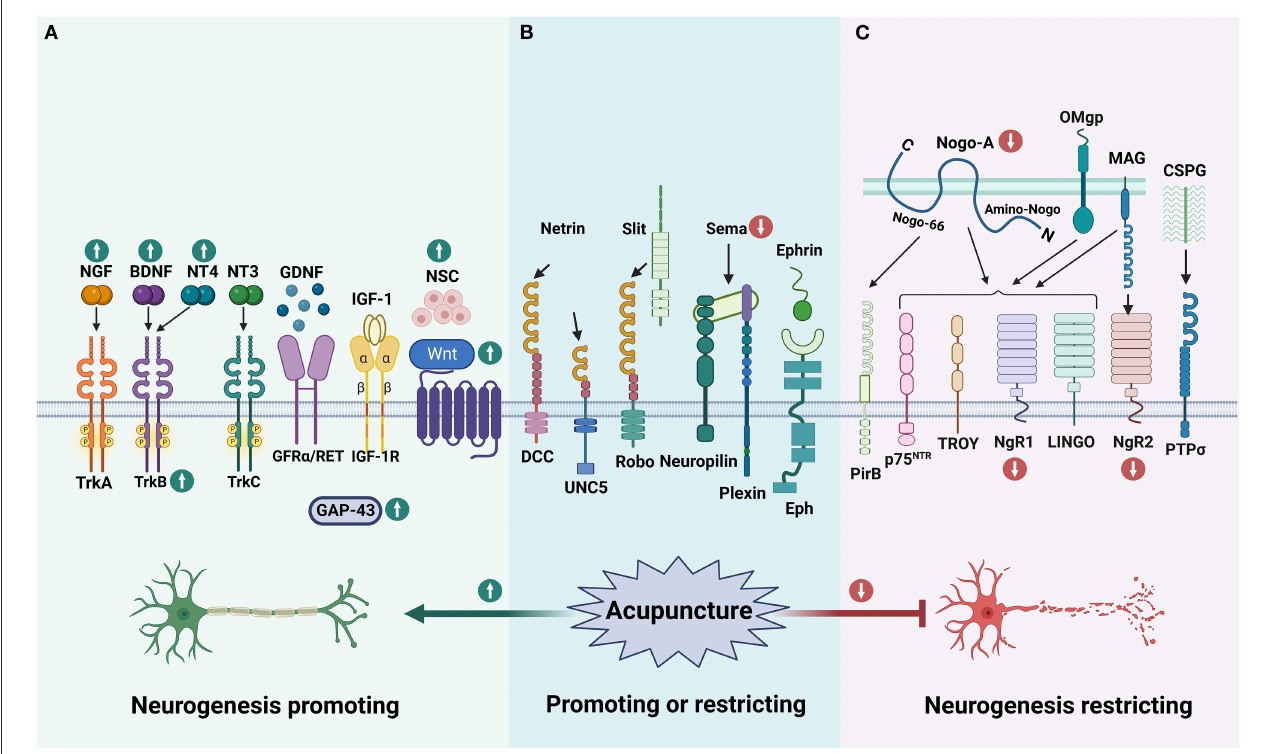
FIGURE4 The effect of acupuncture on neurogenesis impact factors. (A) Shows enhancers for neurogenesis, (B) illustrates guidance cues, and (C) shows inhibitors. According to the currently limited studies, acupuncture promotes neurogenesis and functional recovery after stroke by upregulating some of the enhancing factors of neurogenesis and downregulating the inhibiting factors that affect neurogenesis. The green up arrow represents up-regulation, and the red down arrow represents